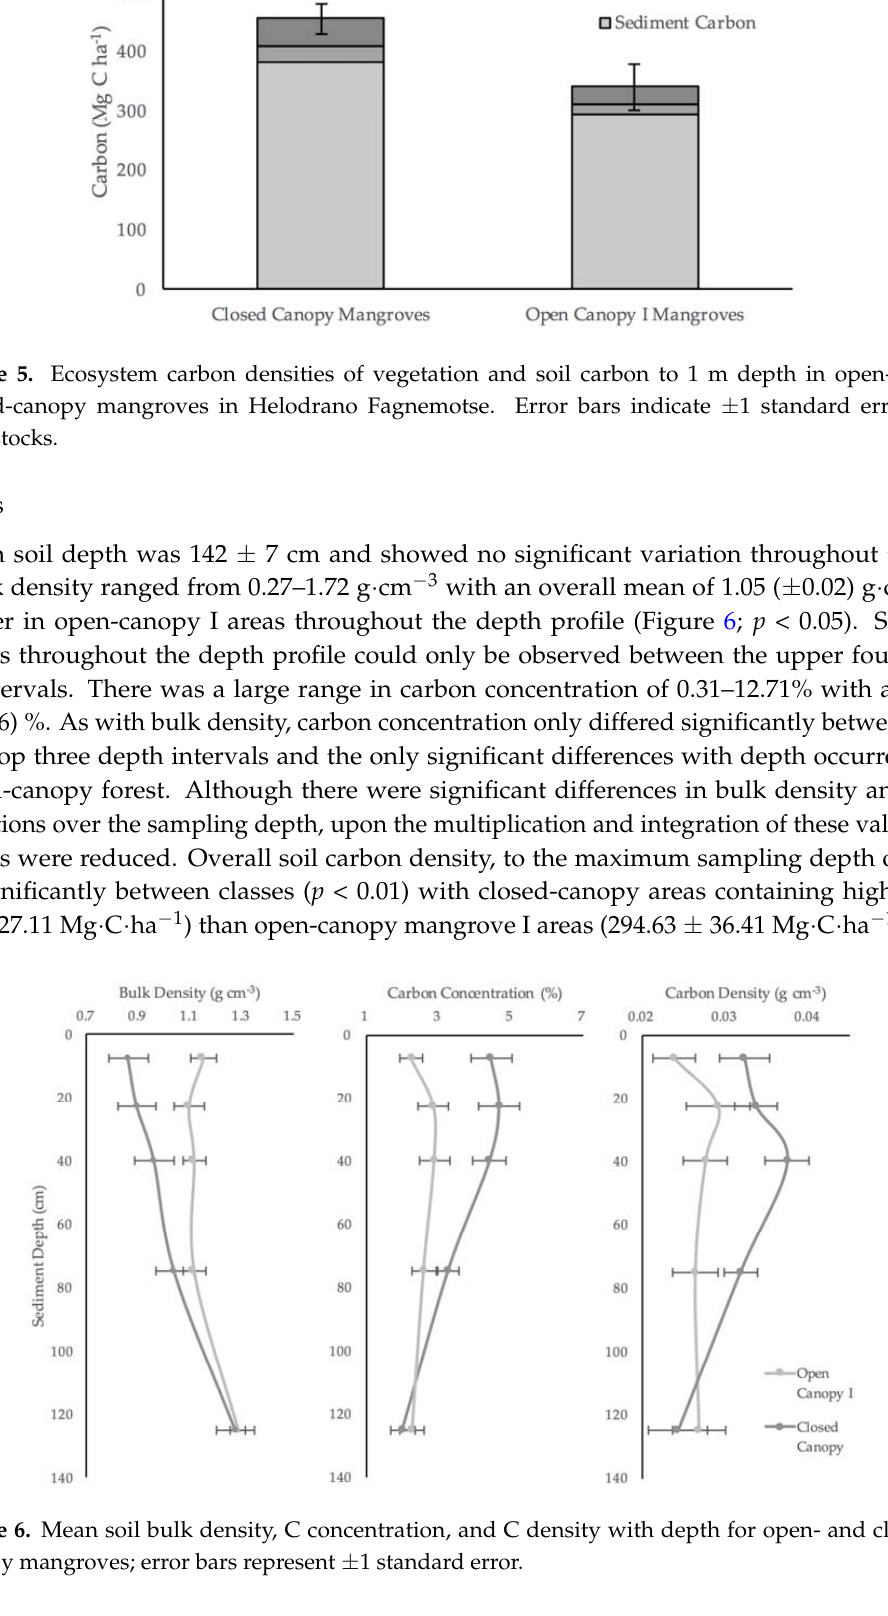
Figure 6. Mean soil bulk density, C concentration, and C density with depth for open- and closed- canopy mangroves; error bars represent ±1 standard error.